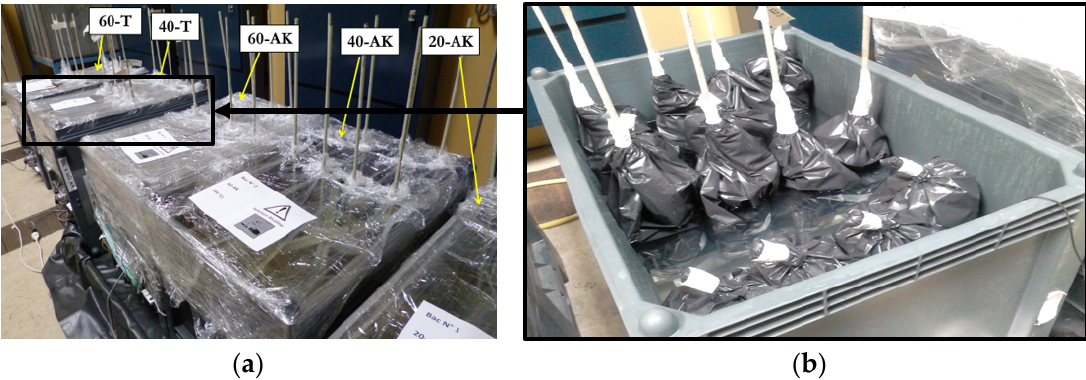
Figure 4. ( a ) Picture of the five thermoregulated tanks and ( b ) detail of the 40-T tank. The alkaline solution was composed of 0.1 mol/L (4 g/L) of sodium hydroxide (NaOH) and 0.5 mol/L (28.05 g/L) of potassium hydroxide (KOH). This solution is commonly used at Eiffel University in the framework of durability/corrosion studies [36,37] because it is suitable for simulating the pore solution of European concretes at early age. It was preferred to the solution recommended by the ACI 440.3R [38]. The pH of the alka- line solution was measured in each tank on the first day of the aging program and after a period of 240 days as well. The corresponding values are reported in Table 1. Initial pH values were close to 13.5 regardless of the temperature of the tank, and they showed very little change after 240 days. Table 1. pH of alkaline solutions in the thermoregulated tanks (data from Ref. [34]). Environment